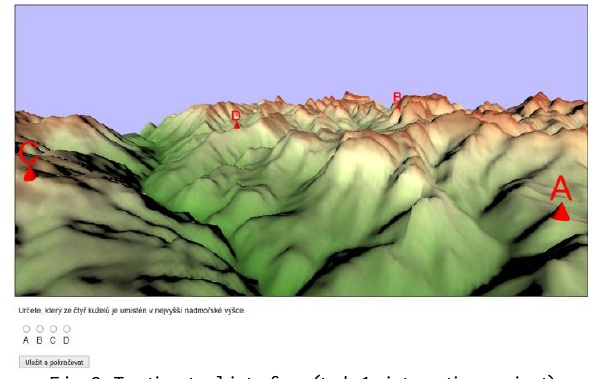
Fig. 2. Testing tool interface (task 1, interactive variant) Speed and accuracy of each task performance of a particular participant were recorded by the testing tool. The movement and actions in a virtual environment were also recorded in detail within the interactive variant. Functions called evt.position and evt.orientation were used to obtain these data (see X3DOM, 2016). Usual JavaScript events, such as onmousedown, are used to detect user interaction and used types of movement.